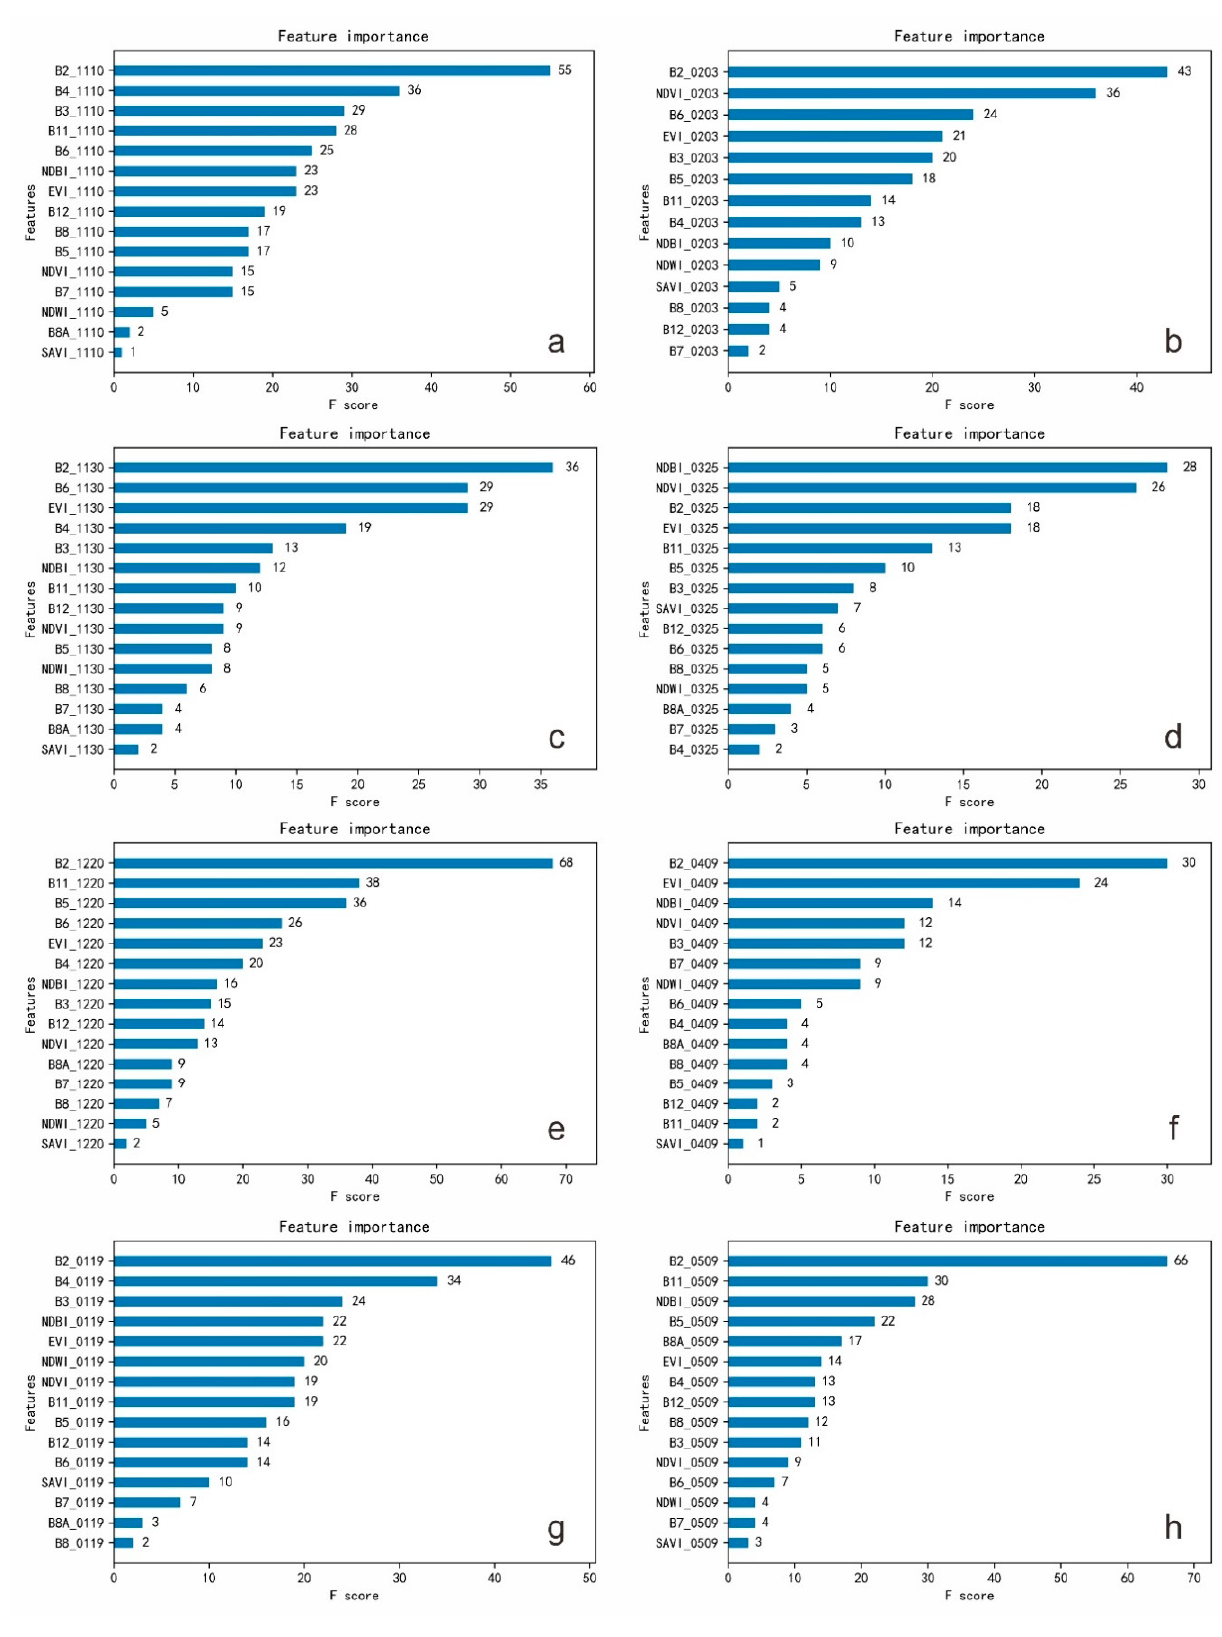
Figure 7. Features importance of fifteen bands in different time series. ( a ) 10 November ( b ) 3 Febru-